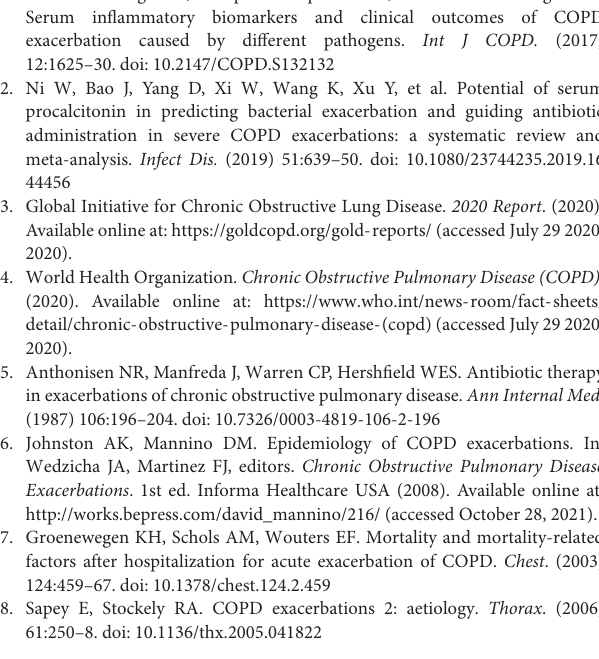
Supplementary Figure 3 | Summary of Methodological Quality Assessment. The graph shows the summary of methodological quality assessment of each study according to each domain of QUADAS-2 tool. The domains of quality assessment include patient selection, index tests, reference standard, flow and timing. Green color with “+” sign represent low risk, yellow color with “?” represent unclear risk and red color with “-” represent high risk of bias. CRP, C-reactive protein; IL-1b, interleukin one beta; IL-8, interleukin eight; MPO, myeloperoxidase; NE, neutrophil elastase; N/L, neutrophil-lymphocyte ratio; PCT, procalcitonin; SAA, serum amyloid A; TNFa, tumor necrosis factor